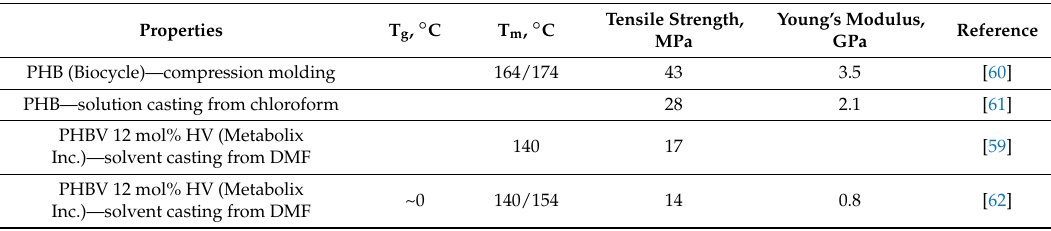
Table 2. Mechanical and thermal properties of some